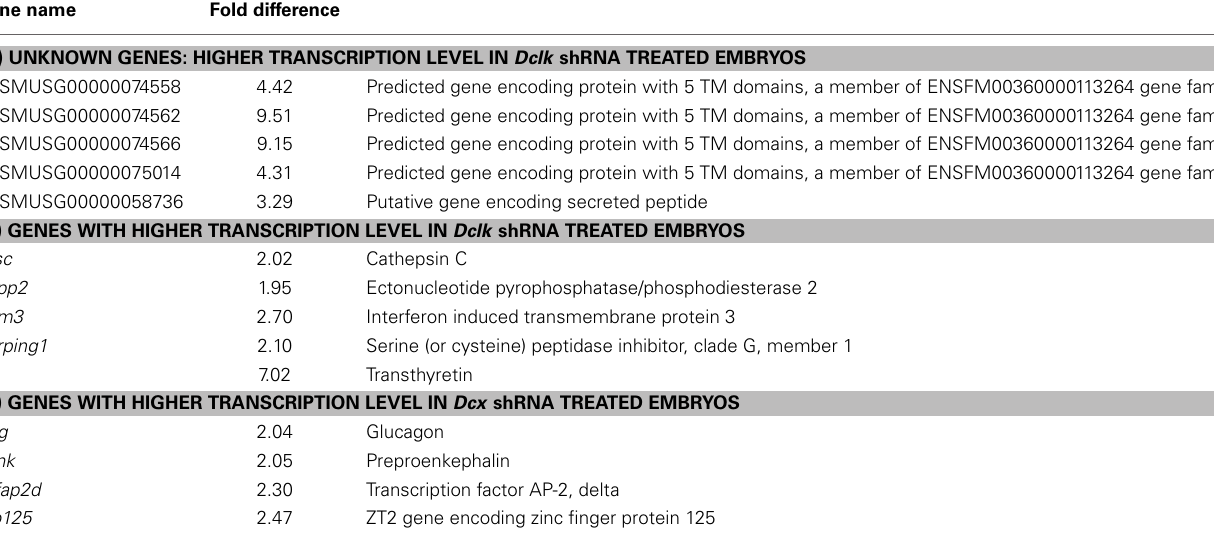
Table 1 | The analyzed results of the Affymetrix